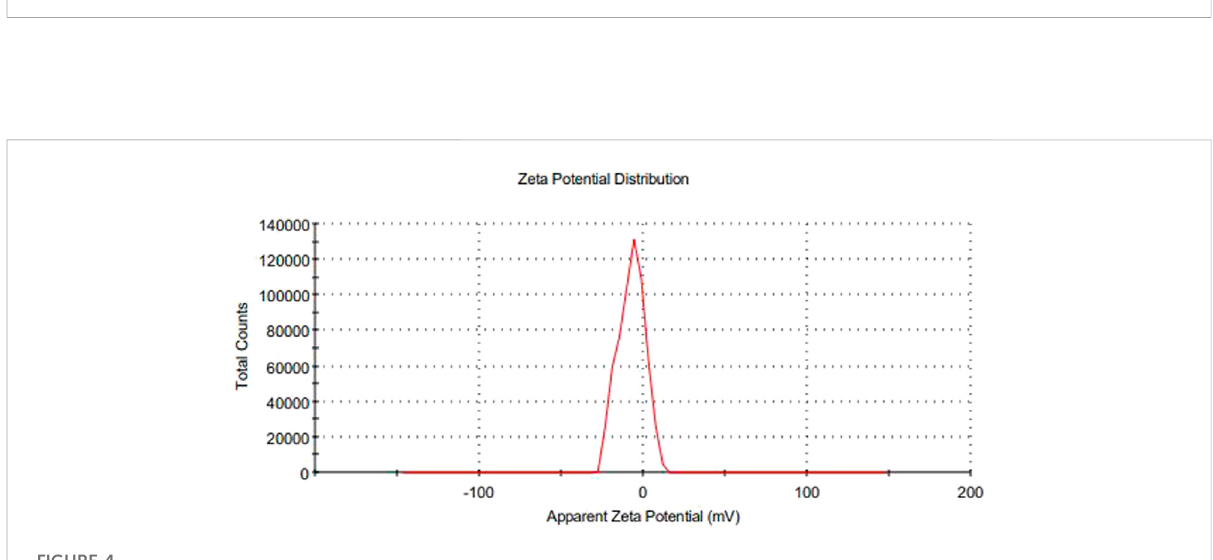
FIGURE 4 The zeta potential of